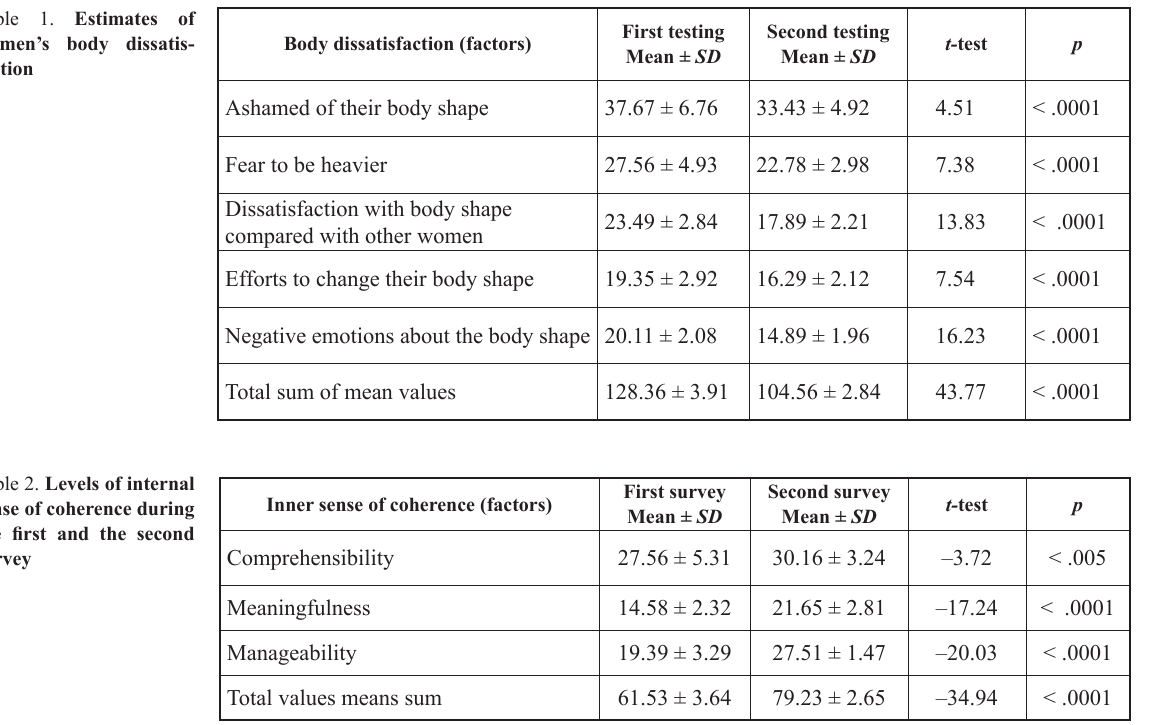
2. Fear to become fat Dissatisfaction with the body 3. shape compared with other